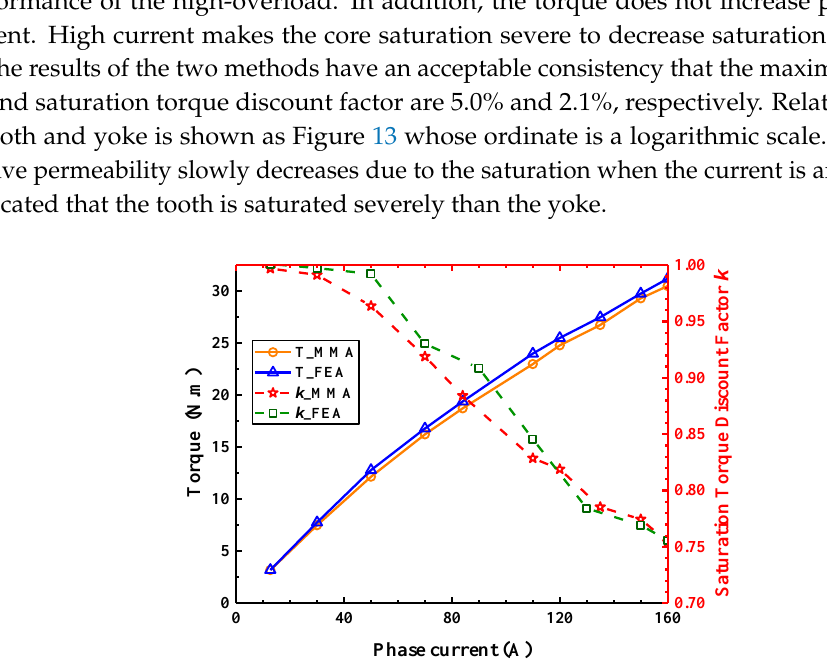
Figure 12. The torque and saturation torque discount factor comparisons at different current.